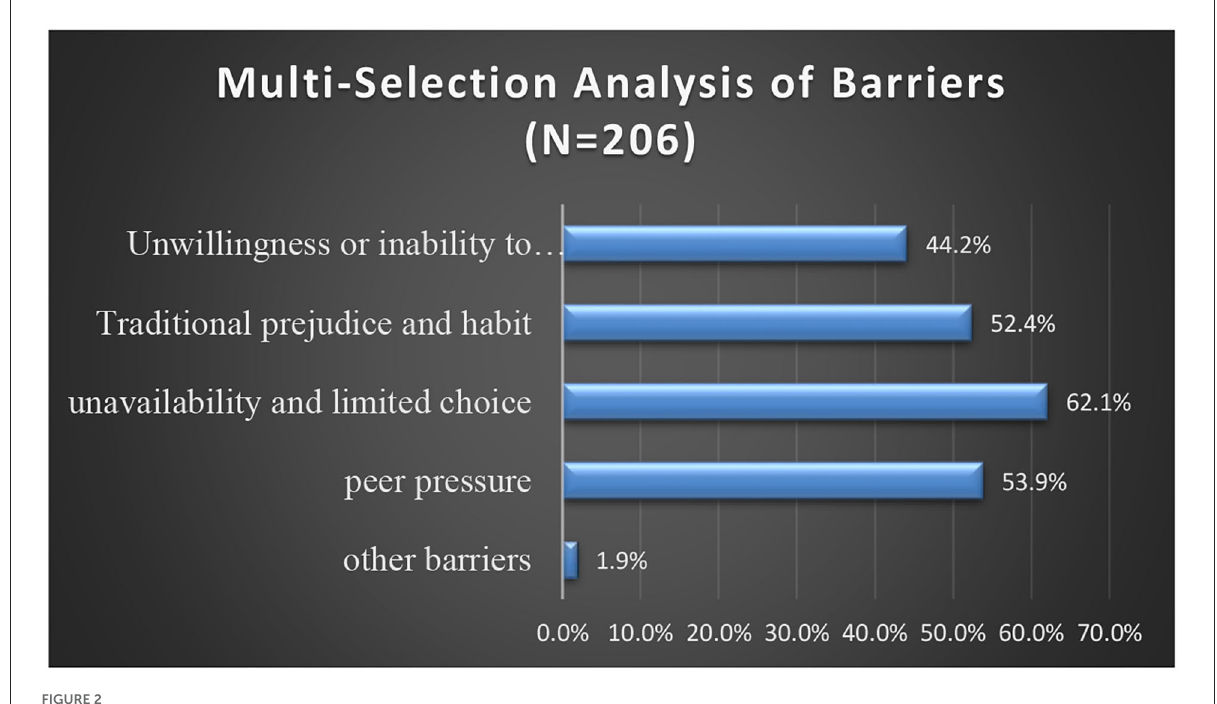
FIGURE2 Barriers for adopting a vegetarian diet.